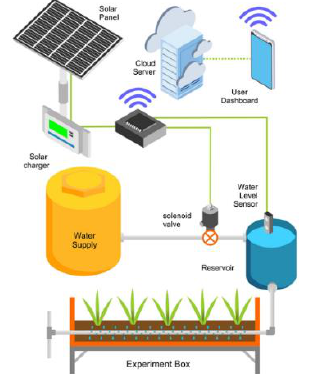
Fig. 3 Scheme (based on [28]) of experimental subsurface irrigation